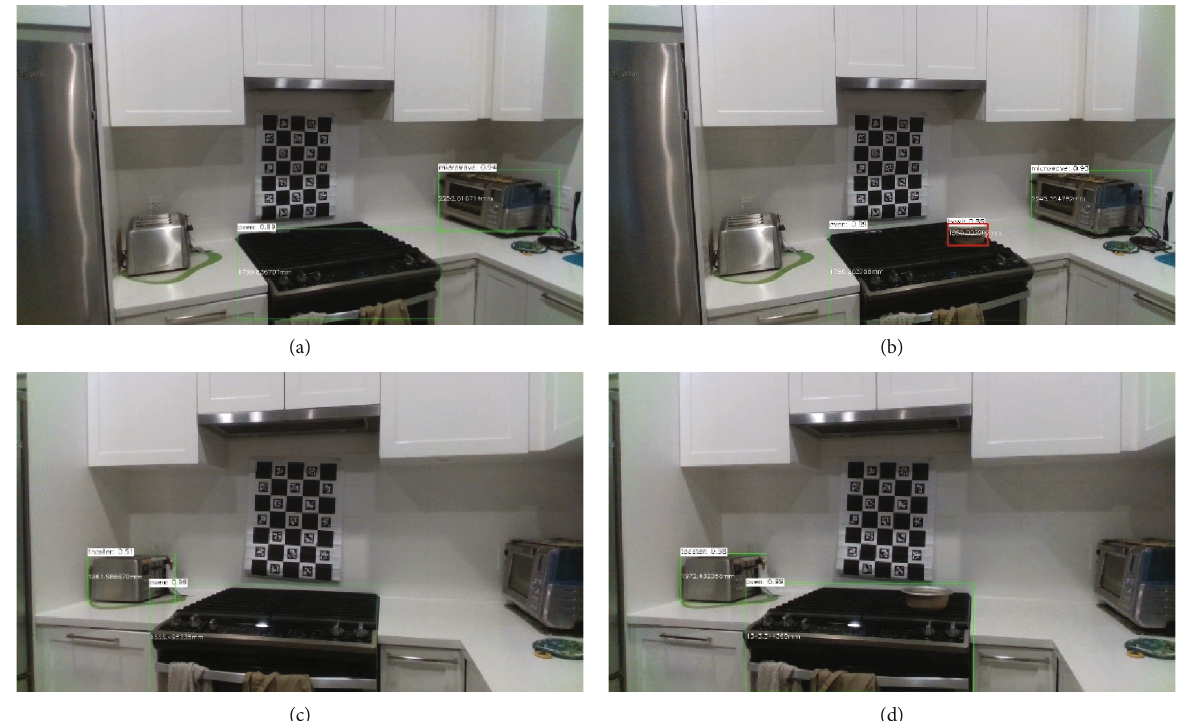
Figure 11: Object detection for before and after the instances when an older adult walks in the kitchen monitoring area and places a cooking bowl on the oven. Left column (a, c) is the detected objects from left (a) and right (c) sensors before an older adult walks into the scene. The right column (b, d) is the detected objects from the left (b) and right (d) sensors when the older adult leaves the scene. Notice the bowl was not detected in the view of the right sensor for when the older adult leaves the room. However, calibration results are used to segment the point cloud in view of the right